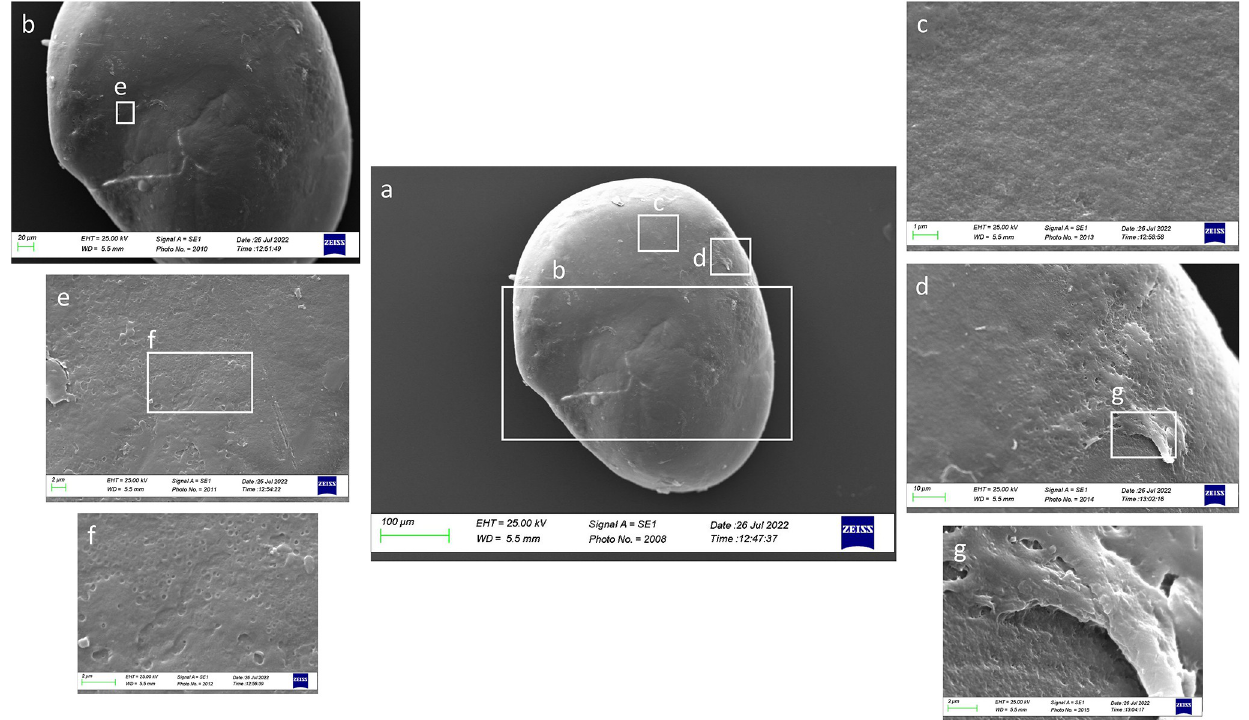
Fig 13. SEM images of a left sagitta inner surface belonging to size Class II (a) with details of sulcus acusticus (b), with its external textural organization (e, f), and crystalline habits of the posterior otoliths zone (c,d,g).